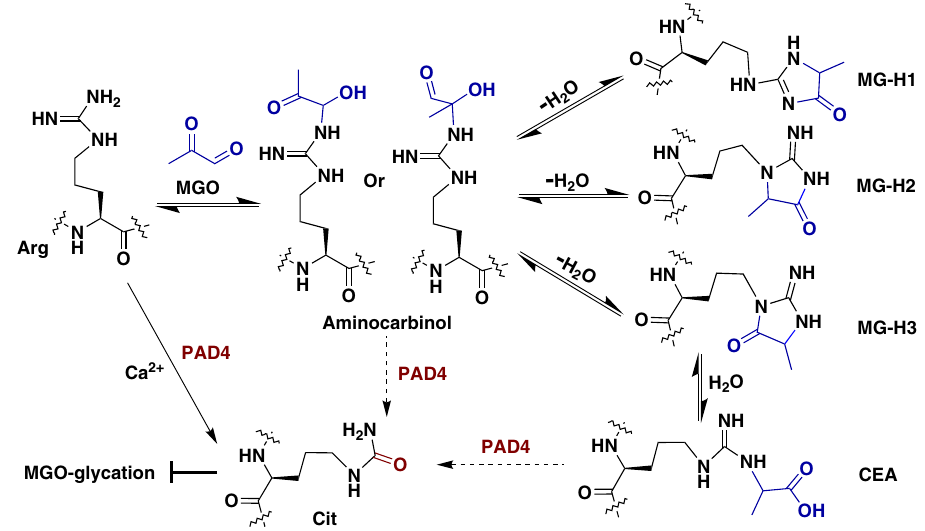
Fig. 1 PAD4 antagonizes methylglyoxal-induced histone glycation. Overall schematic showing MGO-induced histone glycation and citrullination/ deglycation activity of PAD4.